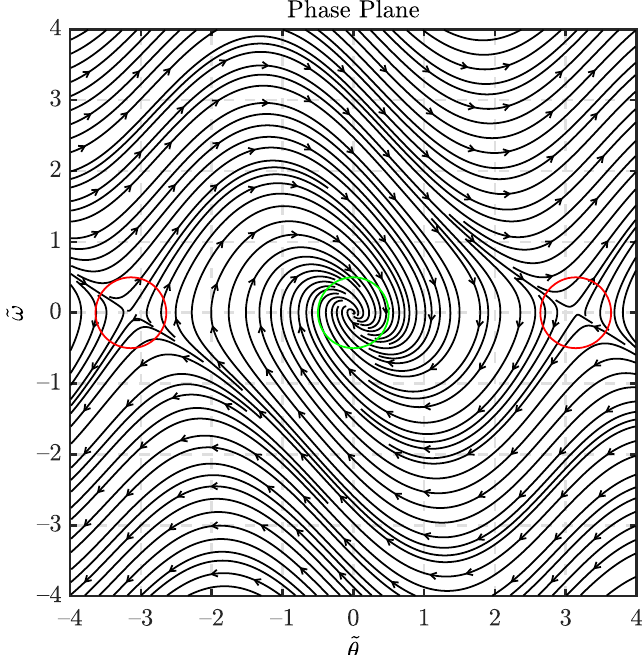
Figure 5. Traditional PLL forward phase plane.